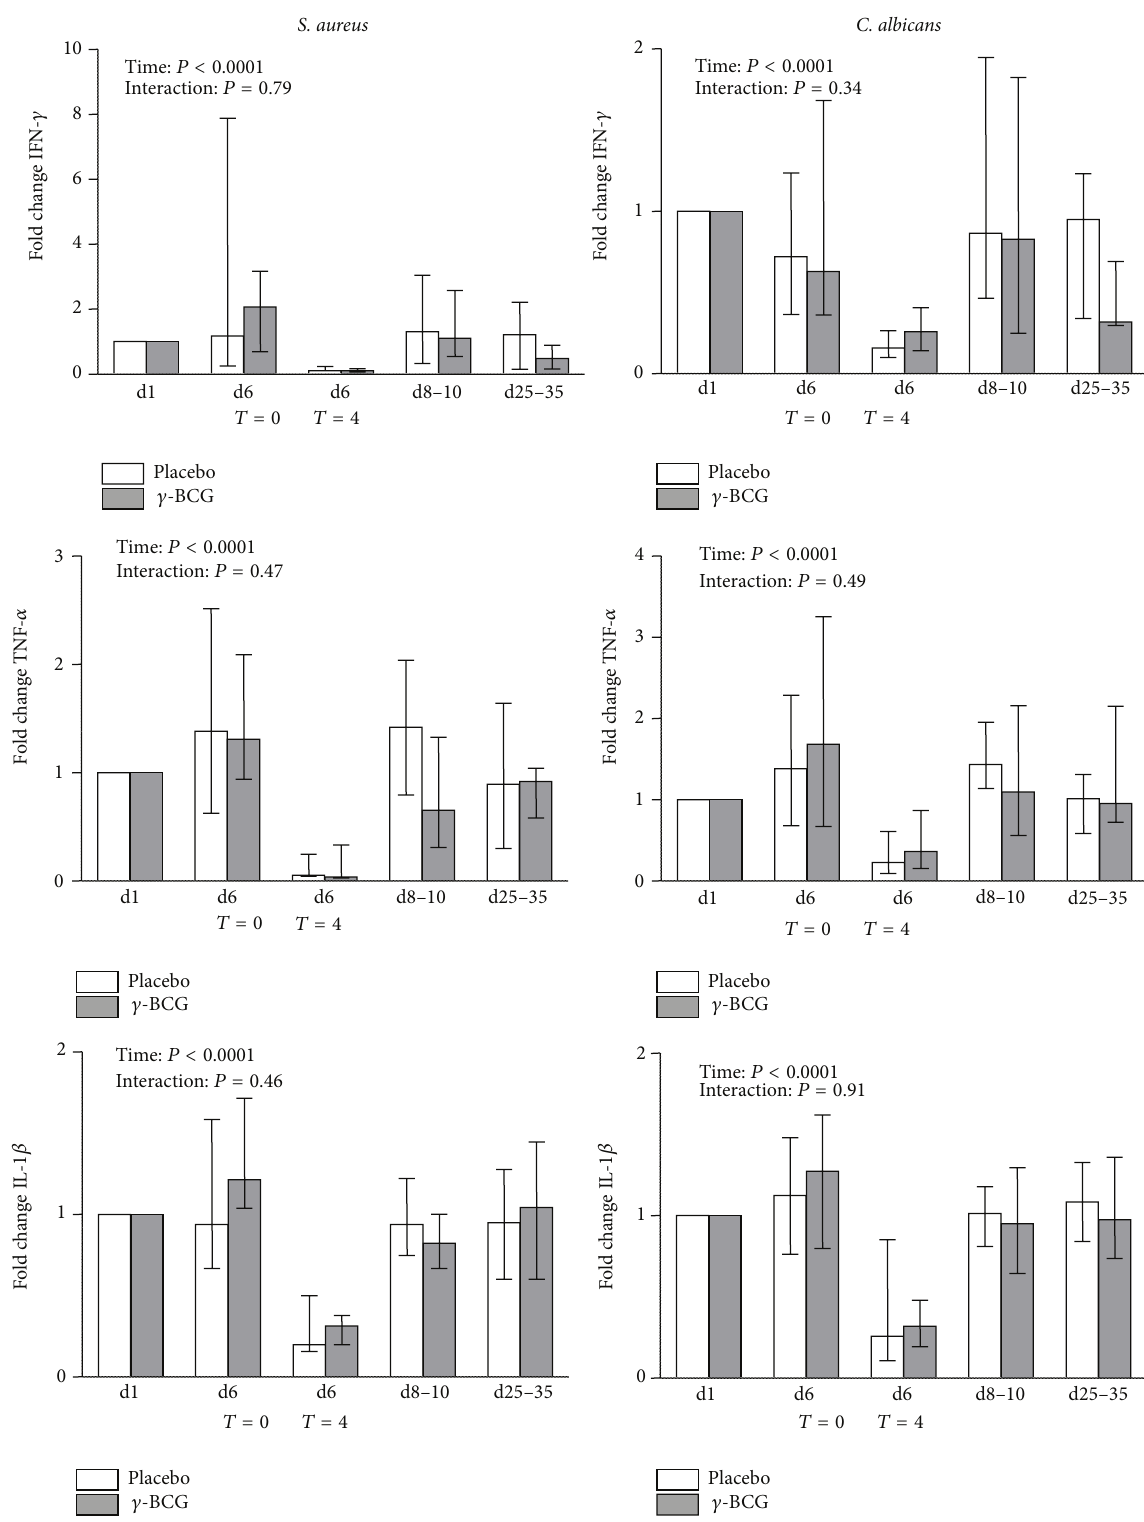
Figure 4: Production of IFN-gamma, TNF- 𝛼 , and IL-1 𝛽 by peripheral blood mononuclear cells stimulated ex vivo with Mycobacterium tuberculosis (MTB), LPS, Staphylococcus aureus (SA), and Candida albicans (CA) of subjects vaccinated with gamma-irradiated BCG or placebo. Data expressed as median and interquartile range of the fold change compared with day 1 (before vaccination) ( 𝑛 = 10 per group). 𝑃 values calculated using repeated measures two-way analysis of variance (ANOVA, time and interaction terms) on log-transformed data. Day 6 was the endotoxemia experiment